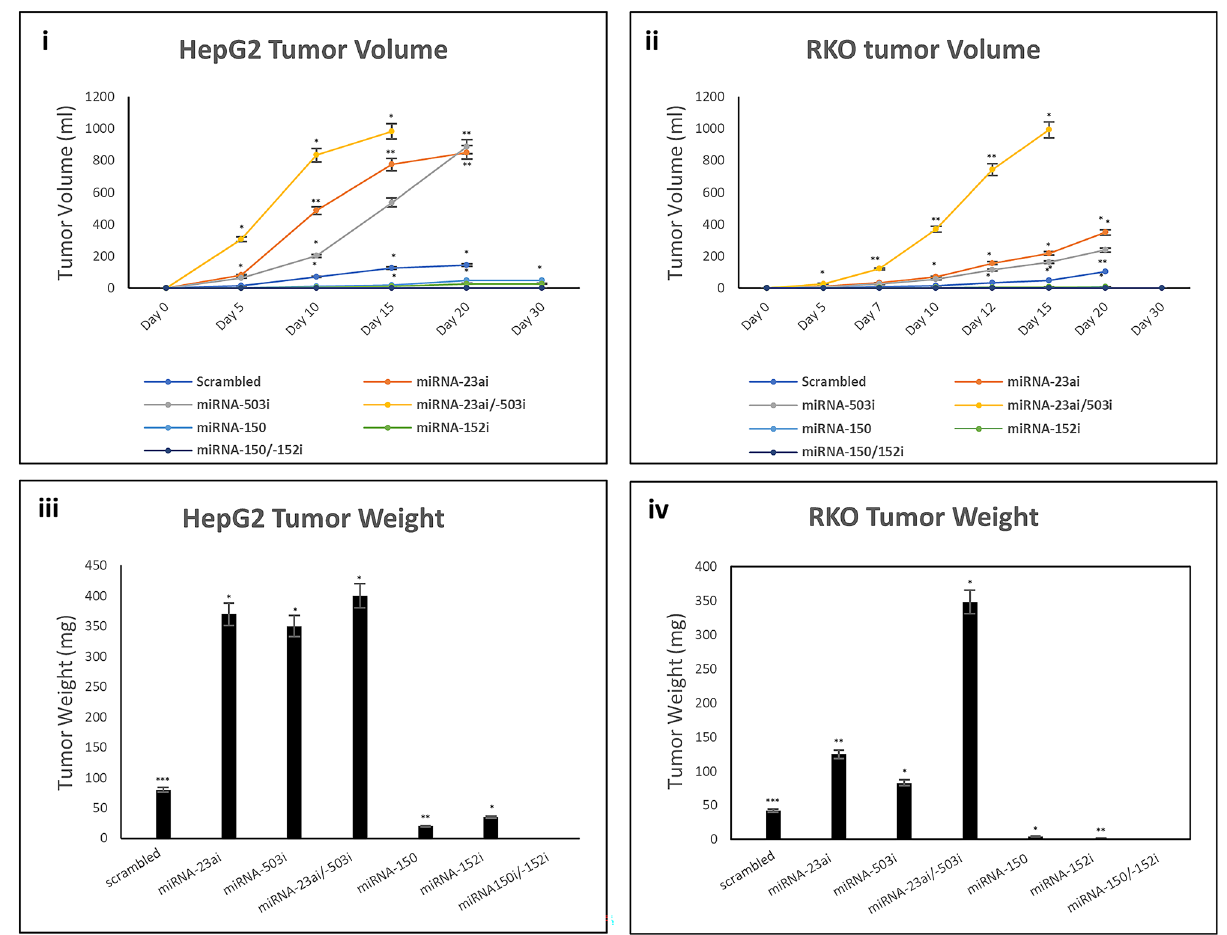
Figure 3. Growth kinetics. Tumor volume (ml) and weight (mg) measurement: tumor volume calculated from the recorded successive tumors in regular intervals using calipers to measure the longest and shortest tumor diameters (volume measurement formula explained in “Materials and methods”). Xenograft Tumor weights measured in nude mice at the end of experiments. (i): HepG2 Tumor Volume (ii): RKO tumor volume (iii): HepG2 tumor weight (iv): RKO tumor weight. Data is representative of three different experiments. *p ≤ 0.05; **p ≤ 0.01; ***p ≤ 0.001; p-values are relative to scrambled vector; SE = standard